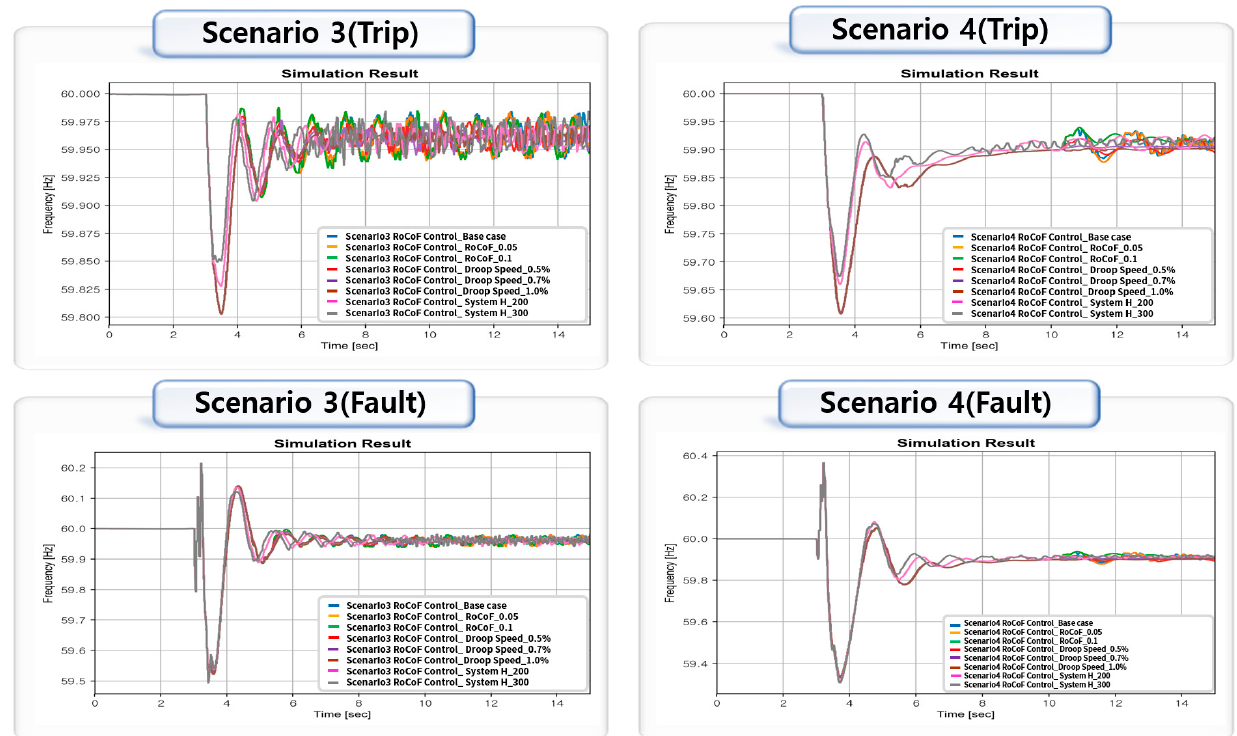
Figure 15. Frequency Response by ESS Parameter (RoCoF Control).